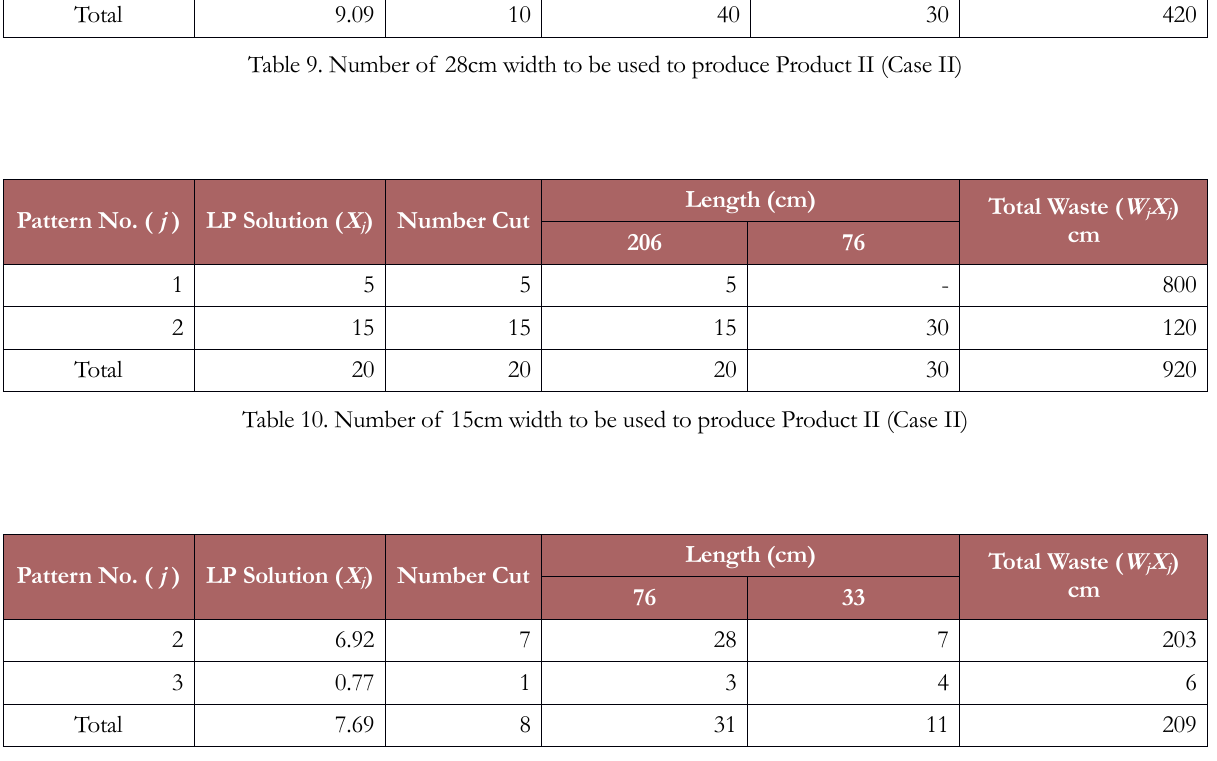
Table 11. Number of 10cm width to be used to produce Product II (Case II)